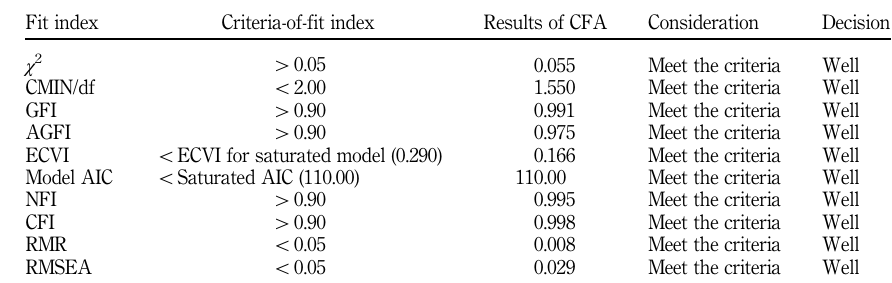
Table V. Statistics measuring the harmony of the model with empirical data of the training program factors to develop the competency of ROO in the VSPO in